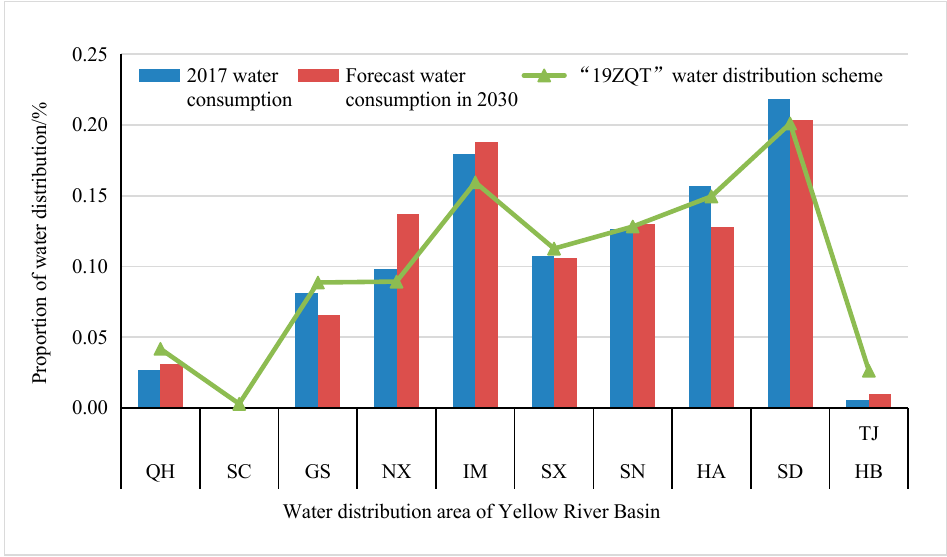
Figure 10. Comparison between the proportion of water allocated under the new scheme, and the proportion of water used in 2017, and projected to be used in 2030, in the Yellow River basin.